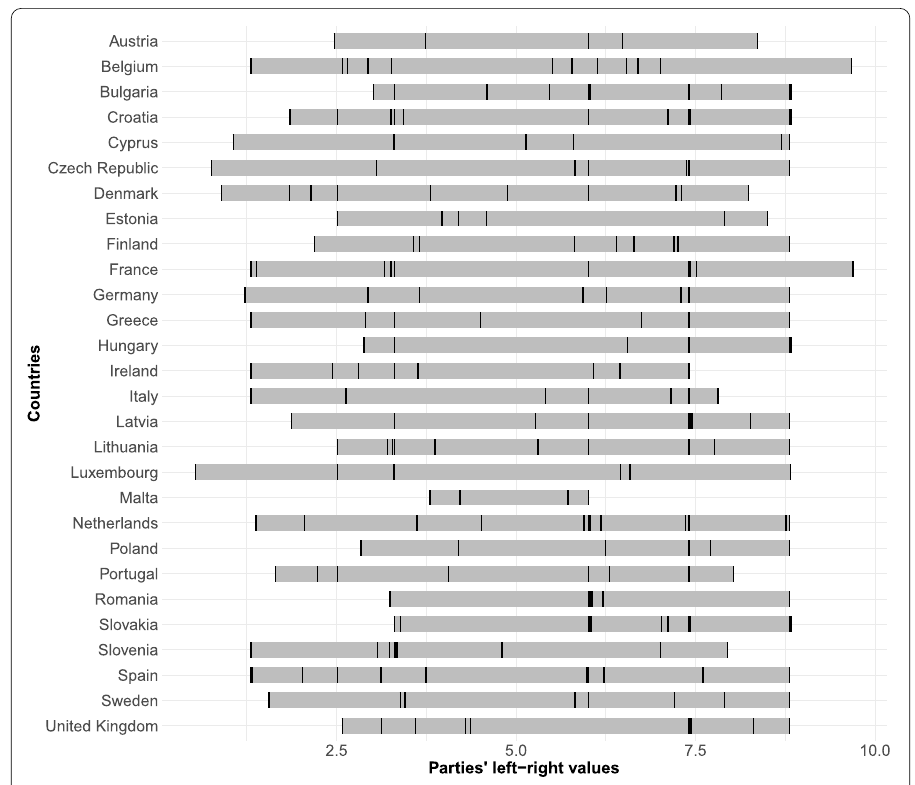
Figure 1 Political parties’ ideology distribution in European countries. Each vertical line represents the ideology of each political party